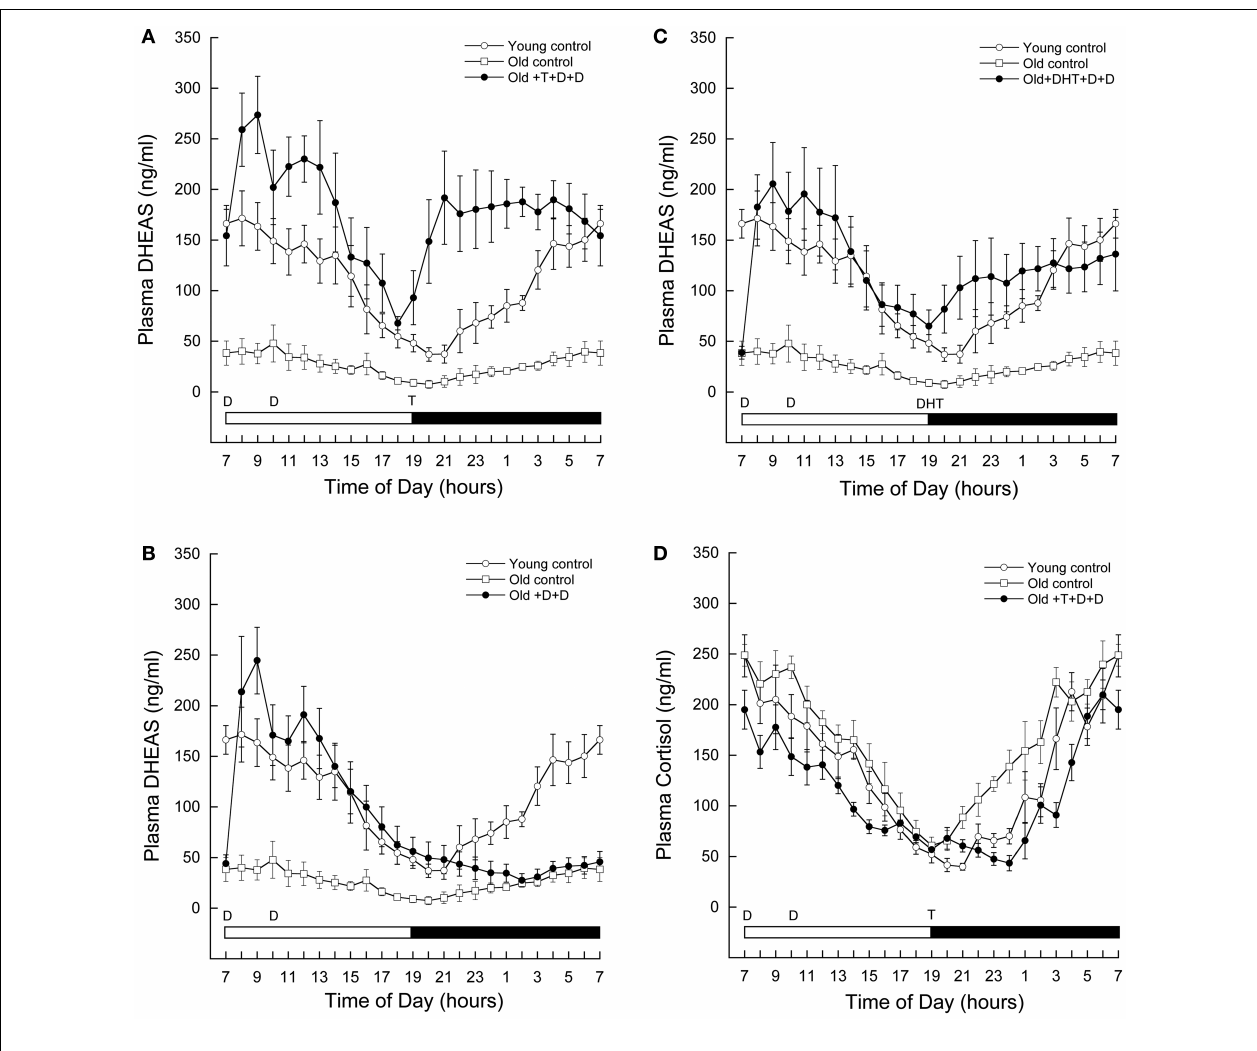
and black bars, respectively. In each panel, the times of oral androgen administration are depicted as follows: D = DHEA (0.04–0.10mg/kg body weight),T = testosterone (12mg/kg body weight), DHT = 5 α -DHT (5–10mg/kg body weight). For reference, the same DHEAS profiles from the young and old controls are depicted in (B–C) .The data demonstrate that androgen supplementation at an appropriate time of day can restore 24-h circulating DHEAS levels in old males rhesus macaques. Importantly, they also demonstrate an unexpected stimulatory action of gonadal steroids on